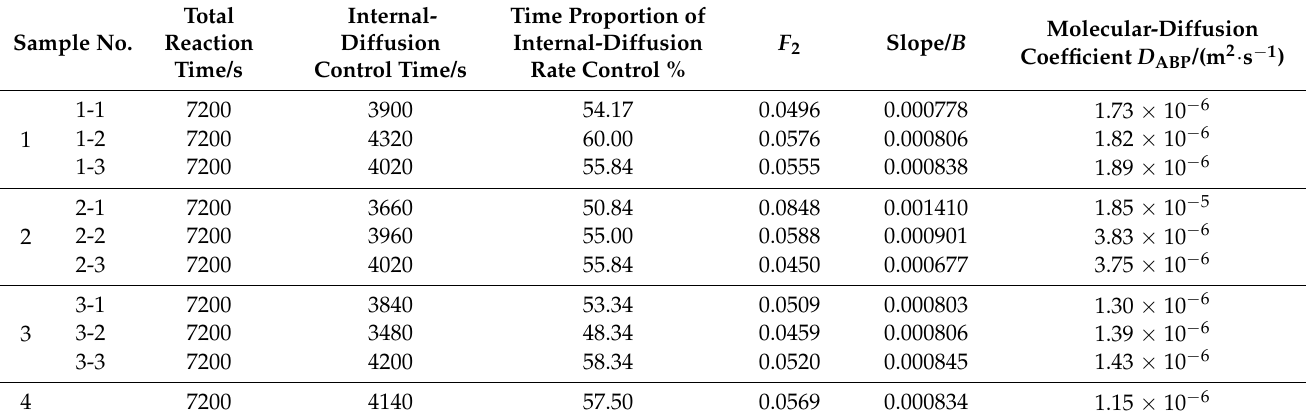
Table 6. Internal-diffusion kinetics parameters during sinter-reduction process at the later